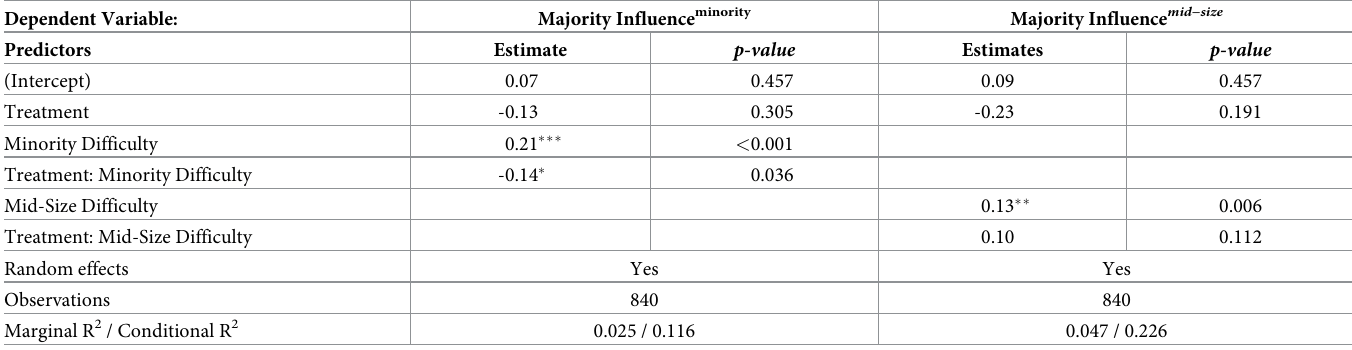
Table 3. Mixed models for majority influence. The VAE bot significantly reduced the majority cluster’s influence on the 2-person minority cluster. A significant interac- tion between treatment and difficult was also found, suggesting that presence of the VAE bot further reduced majority cluster’s influence in difficult trials. Dependent